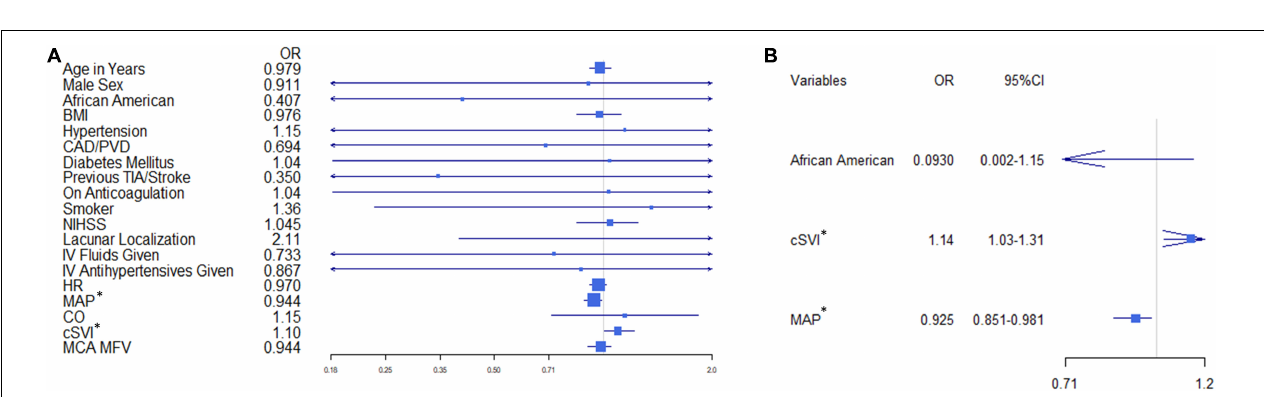
FIGURE 2 | Univariate and multivariate odds ratio (OR) forest plots. Shows the OR forest plot for each variable with confidence intervals for (A) univariate and (B) multivariate models. ∗ P < 0.05.